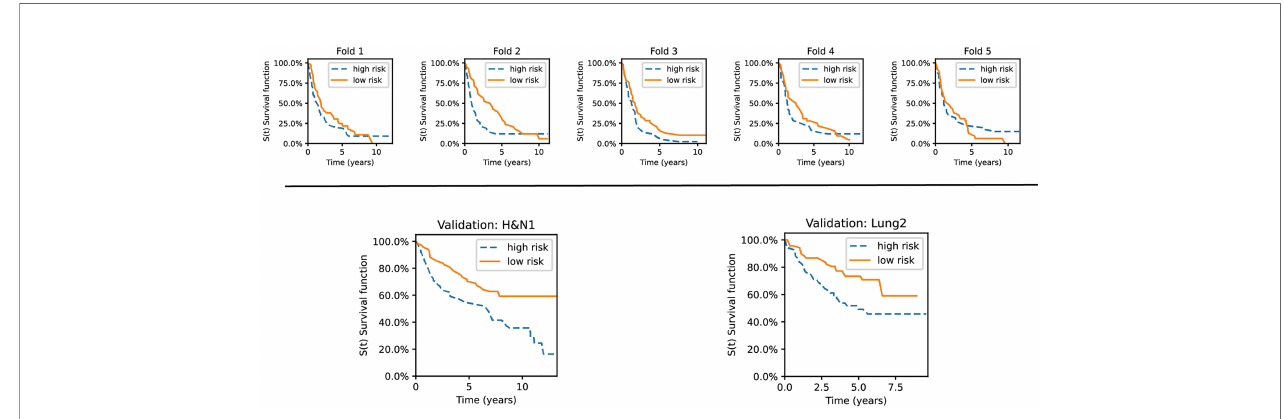
FIGURE 9 | Kaplan – Meier curves for the validation sets used in the experiments. The datasets are strati fi ed into low- and high-risk groups based on the risk predictions of our best-performing method. Top row: survival curves from fi ve individual folds from Lung1. Bottom: The model was trained on Lung1 and evaluated on the Lung3 (right) and H&N1 (left)